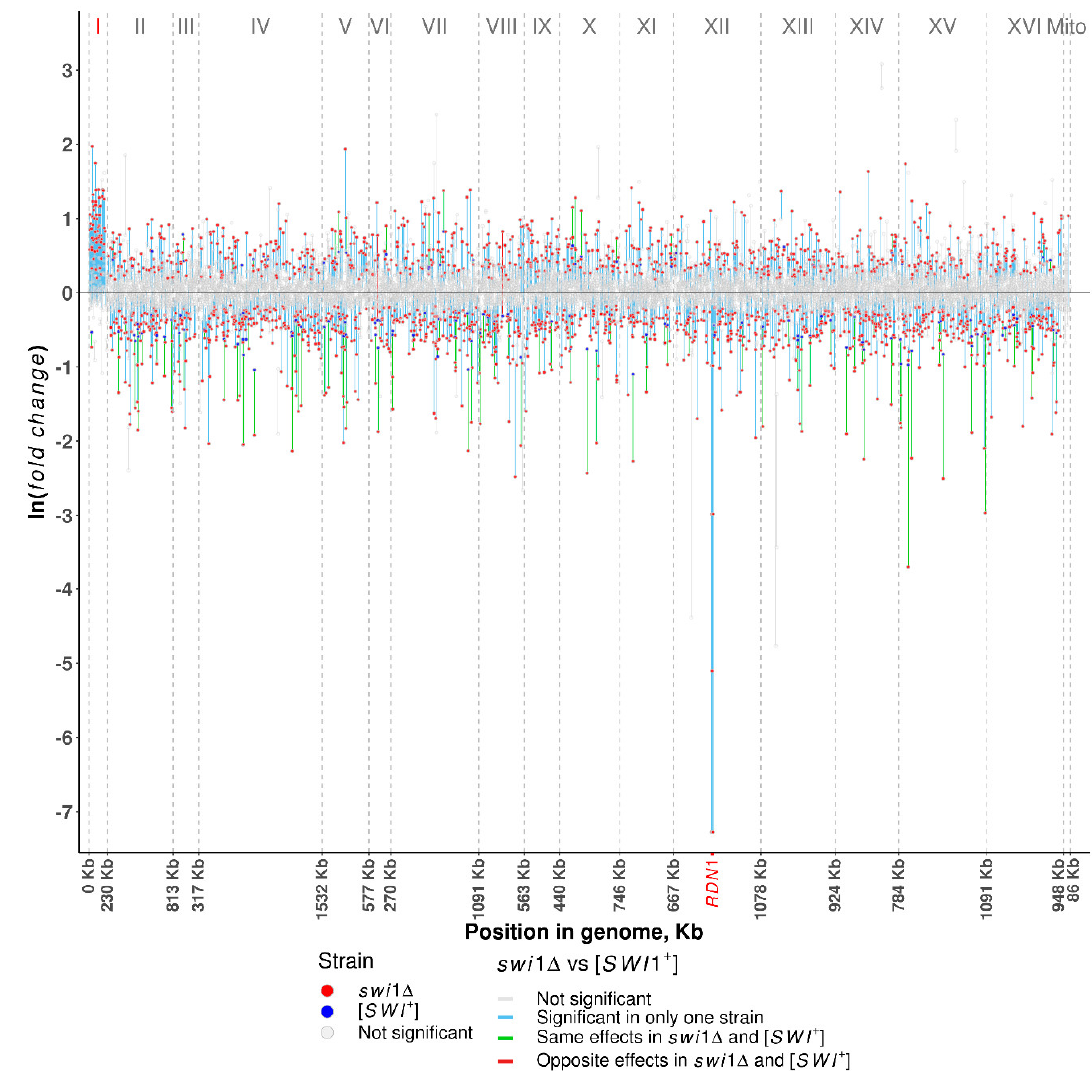
Figure 2. Distribution of differentially expressed genes along the chromosomes. Plotted on the y -axis is the ln fold difference between the swi1 Δ or [ SWI + ] and [ swi − ] strains. Plotted on the x -axis are genomic coordinates. Vertical dashed lines denote the borders of chromosomes with the length of chromosomes shown on the x- axis and the name of chromosomes shown in the upper part of the plot. Red dots denote the significant (FDR < 0.001) changes in the swi1 Δ and blue dots denote the significant changes in the [ SWI + ] strains. Grey dots denote nonsignificant changes in all strains. Lines connecting changes in the same genes, are (i) grey when changes in both swi1 Δ and [ SWI + ] strains are nonsignificant, (ii) blue when change is significant in only one strain ( swi1 Δ or [ SWI + ]), (iii) green when a gene is up- or downregulated in both swi1 Δ and [ SWI + ] strains, and (iv) red when a gene is upregulated in one strain and downregulated in another.